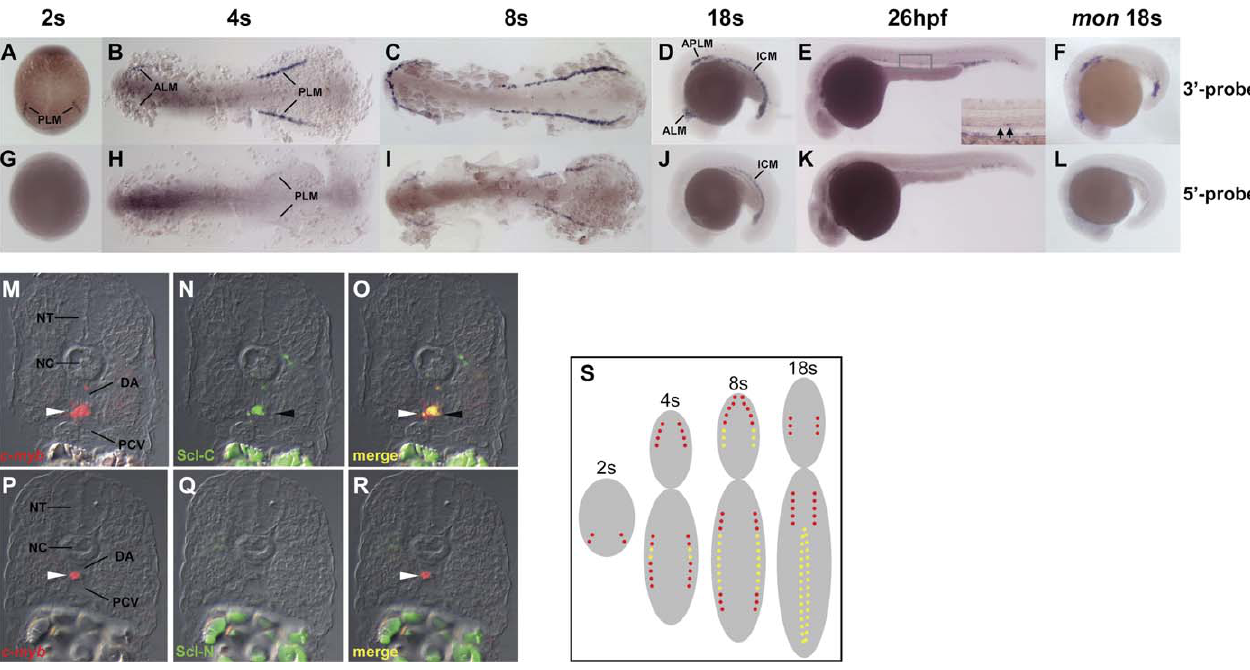
Figure 2. Distinct Expression Pattern of scl- a and - b during Early Embryonic Development (A–L) Examination of scl- a and - b expression by WISH in wild-type and mon mutant embryos. WISH was performed in 2-somite (s) (A and G), 4-somite (B and H), 8-somite (C and I), 18-somite (D and J), and 26-hpf (E and K) wild-type embryos, and 18-somite mon mutant embryos (F and L). The 3 9 -probe (A– F) detected the expression of both scl- a and - b , whereas the 5 9 -probe (G–L) detected scl- a expression. The arrows indicate the expression of scl- b (E), but not scl- a (K), in the ventral wall of DA. Embryos are in dorsal (A and G), flat-mounted dorsal (B, C, H, and I), and lateral (D–F and J–L) views with anterior to the top (A and G) or the left (B–F and H–L). (M–R) Transverse sections through the trunk region of 26-hpf wild-type embryos with dorsal up. Fluorescence in situ hybridization showed the expression of c-myb in the ventral wall of DA (white arrowhead in [M, O, P, and R]). Immunochemistry staining showed that Ab-Scl-C (black arrowhead in [N and O]) but not Ab-Scl-N (Q) detected Scl expression in the ventral wall of DA, demonstrating the co-localization of scl- b and c-myb in the ventral wall of DA (O). NC, notochord; NT, neural tube; PCV, posterior cardinal vein. (S) Schematic diagram in flat-mounted dorsal view to illustrate the temporal and spatial expression of scl- a and - b . Red represents scl- b expression, whereas yellow indicates scl- a / b co-expression.